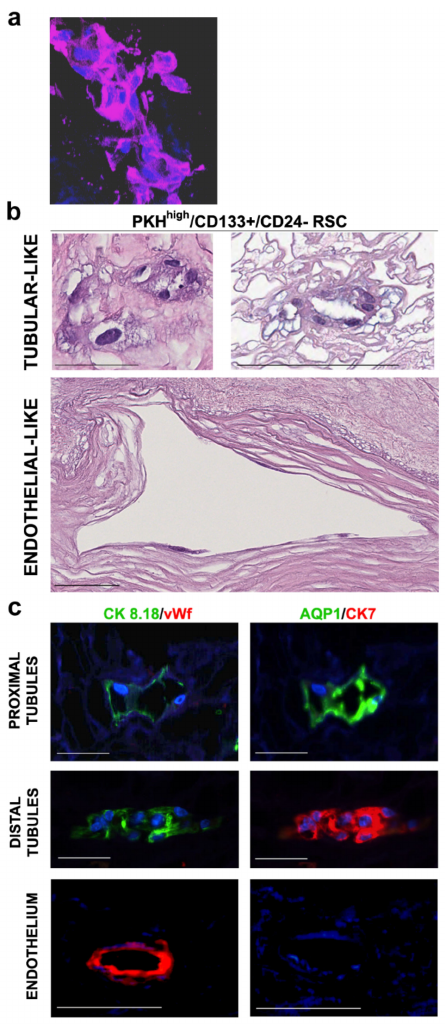
Figure 1. Histological characterization of the decellularized sca ff olds repopulated with adult renal stem-like PKH high / CD133 +/ CD24 − cells (RSC). ( a ) Representative Z-stack 3D reconstruction of images after DAPI (blue) and phalloidin (purple) immunofluorescence staining of the sca ff olds at 30 days after RSC seeding. Total thicknesses of the shown structure was 31.2- µ m original magnification, × 400; ( b – c ) five independent experiments of human kidney sca ff old repopulation for 30 days with RSC in presence of basal medium were performed; ( b ) representative Hematoxylin and Eosin (H&E) staining of formalin fixed, para ffi n embedded (FFPE) repopulated sca ff old sections. Scale bars, 100 µ m; ( c ) representative sequential IF analysis of the FFPE-repopulated sca ff olds with the antibodies against the indicated markers that recognize specific tubular or vascular phenotypes. The di ff erent antibodies combinations identify proximal tubules (top), distal tubules (middle) and endothelium (bottom). Scale bars, 50 µ m. CK—Cytokeratin; AQP—Aquaporin; vWf—Von Willebrand Factor;